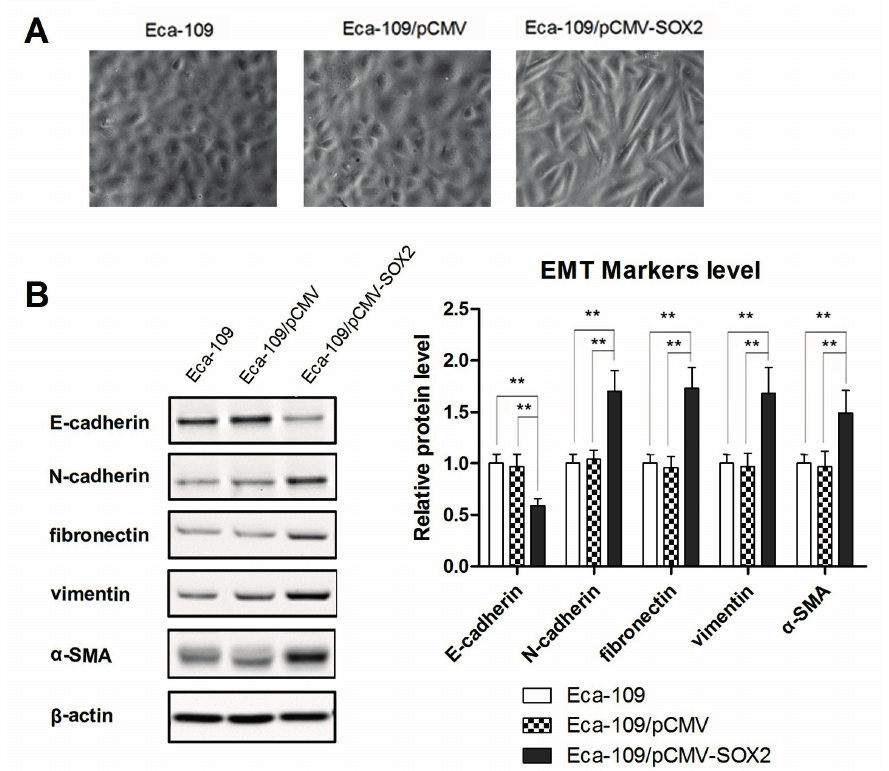
Figure 2. SOX2 over expression promotes the EMT process. ( A ) Phase-contrast microscopy images showing the effect of SOX2 over expression on cell morphology; ( B ) Western blot showing the effect of SOX2 on the expressions of epithelial and mesenchymal cells markers (E-cadherin, N-cadherin, vimentin, fibronectin and α -SMA). Data are represented as mean ± SD of three independently conducted experiments. ** indicates p < 0.01. The microscopic images (20× magnification) and Western blots are representatives of three independent experiments (The other two western blot image were provided as Figure